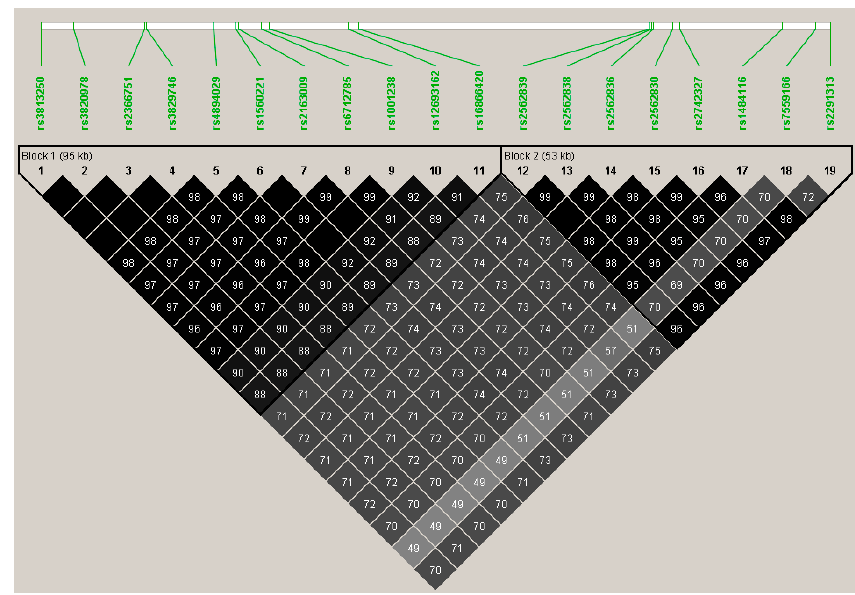
Figure 3. TTN variants, p < 0.05, linkage disequilibrium plot. Two missense variants were significant at TTN , but did not withstand Bonferroni correction for testing 275 variants at this locus: rs3829746/Ile26134Val and rs1001238/Asn17060Asp, ( p = 0.04, r 2 = 0.98).